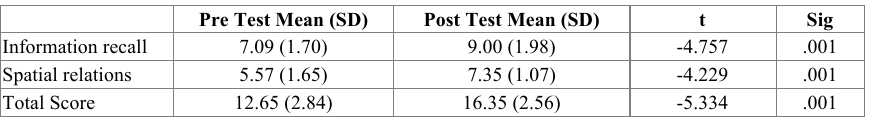
Table 1. Pre/Post test